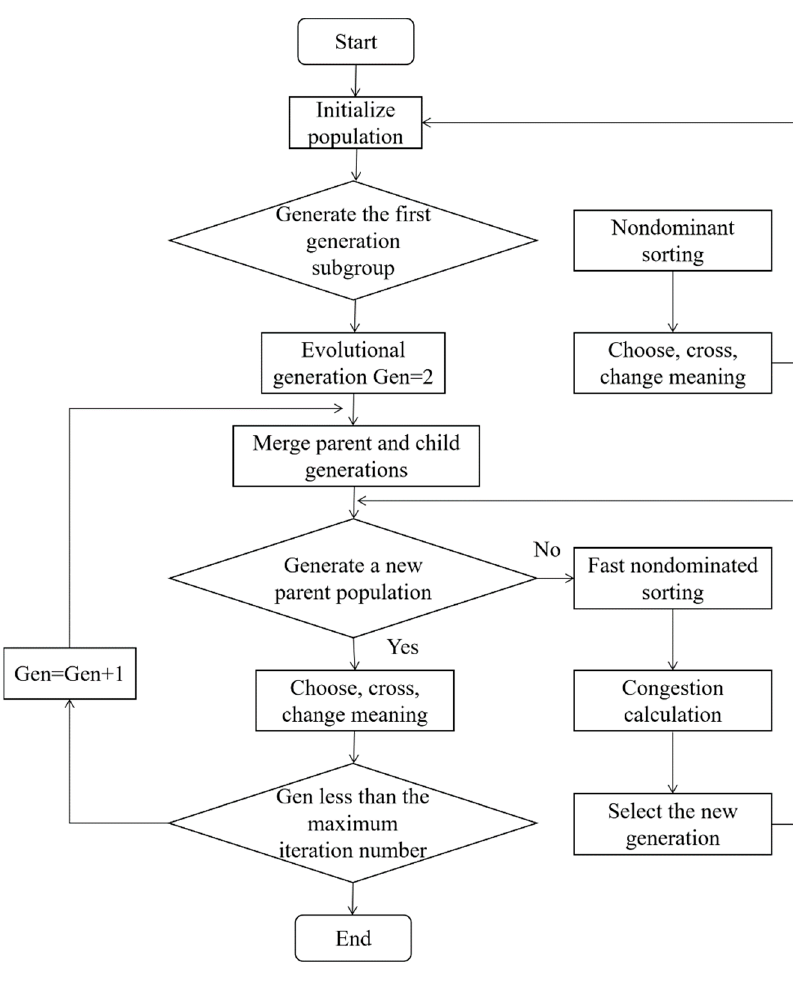
Figure 1. The basic process framework of the NSGA-II algorithm.